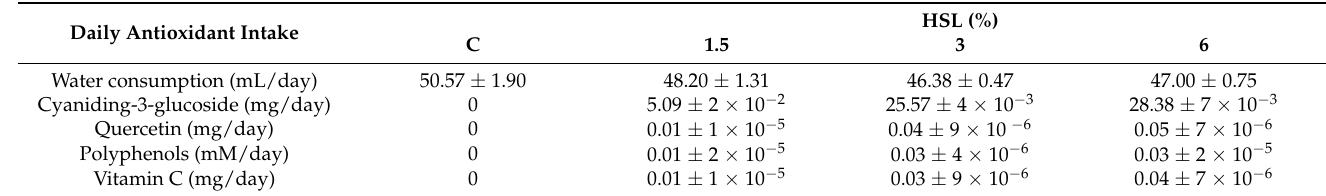
Table 1. Corresponds equivalence of the antioxidants and the water that consumed per